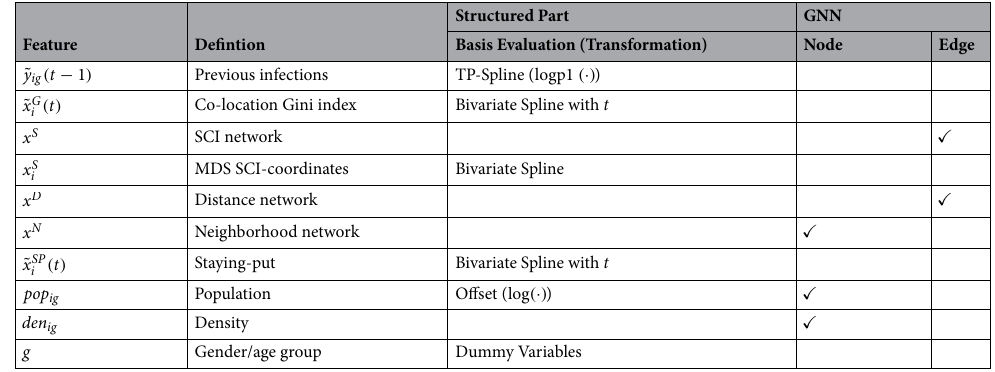
Table 1. Features and their incorporation into the structured and GNN part of the proposed model. For each feature, the second column indicates the basis function evaluation used in the structured part, which is applied to the the feature itself or a transformation of it given in brackets. If no transformation is given, the identity is used. Bivariate thin plate (TP) regression splines are used to model bivariate effects. The logp1 transformation is given by logp1 ( y ) = log ( y + 1 ) . The third column indicates the incorporation of each feature in the GNN part, either as a node or edge feature. To also account for the group-specific nature of each distributional parameter, gender and age effects are added using g as a dummy